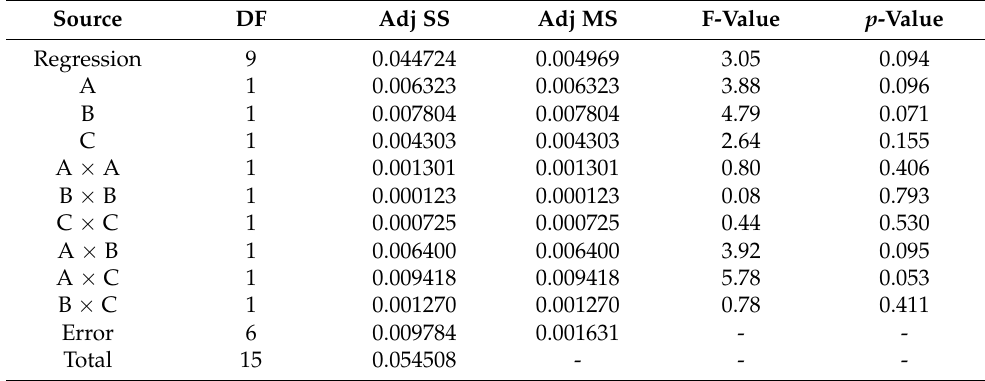
Table 7. ANOVA results obtained for corresponding overcut values.